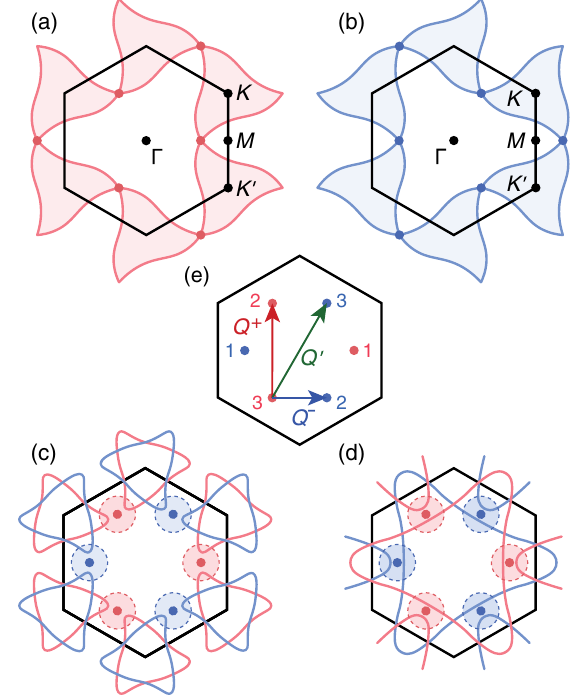
FIG. 1. (a),(b) Two Fermi surfaces at the Van Hove energy from different valleys shown in red and blue, reproduced from the band structure calculation for twisted bilayer graphene with θ ¼ 2 ° [28]. Shaded areas are filled and VHS appear at the points, where two Fermi surfaces encircling K and K 0 touch. Each Fermi surface has C 3 symmetry about Γ , K , and K 0 . The Fermi surfaces in (a) and (b) are related by C 2 rotation with respect to an in-plane axis along Γ - K . (c),(d) Fermi surfaces slightly away from the Van Hove energy. The carrier density is lower than that at the Van Hove energy in (c) and higher in (d). DOS is larger near the VHS points (hot spots), where electron interaction predominates. We assign patches (circles with dashed lines) centered at hot spots. (e) Three inequivalent wave vectors ( Q þ , Q − , and Q 0 ), along with sym- metry-related ones (not shown), connect various pairs of hot